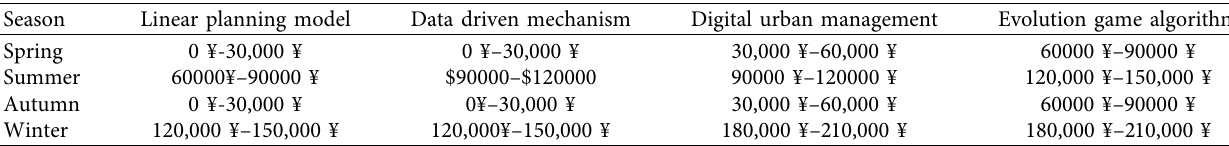
Figure 5: Model optimization effect test. Note: won the horizontal axis means 10000 yuan. (a) The community sports facilities configuration for spring performance. (b) Provide community sports facilities for summer performance. (c) Autumn performance of community sports facilities configuration. (d) The sports facilities in the community configure winter performance. Table 1: The performance optimization coefficient is zero capital investment